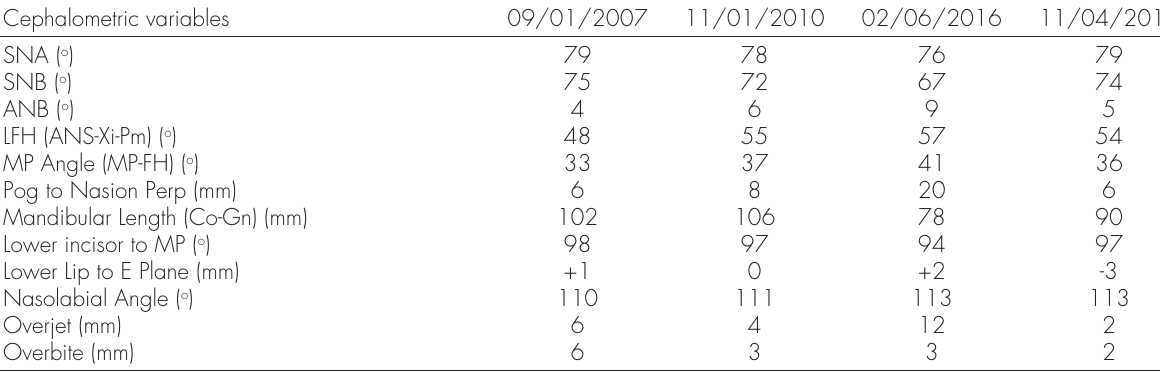
Table II. Serial cephalometric measurements. Cephalometric variables